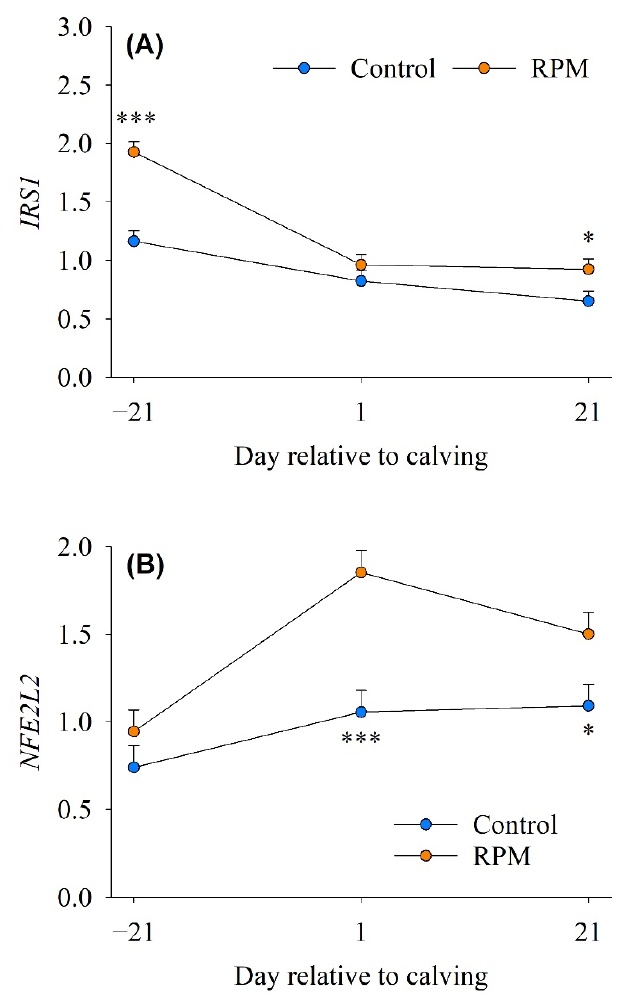
Figure 3. mRNA abundance of genes associated with insulin signaling and antioxidant response in skeletal muscle of dairy cows ( n = 10/diet) fed a basal control diet or the basal diet plus ethyl-cellulose rumen-protected methionine (RPM) from − 21 to 21 day of calving. ( Panel A ), insulin receptor substrate 1 ( IRS1 ); ( Panel B ), NFE2 like bZIP transcription factor 2 ( NFE2L2 ). Error bars represent SEM. * p < 0.05, *** p < 0.001.